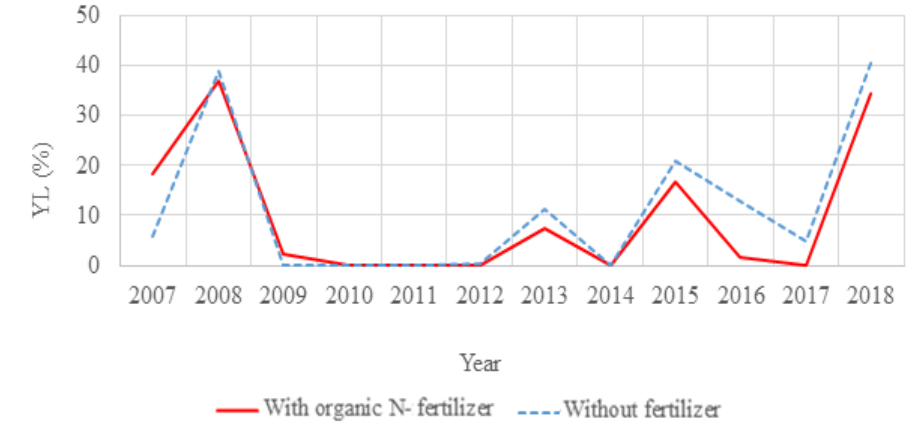
Figure 9. Annual herbage yield loss (as %) in the study area under the two different fertilizer managements (2007–2018).